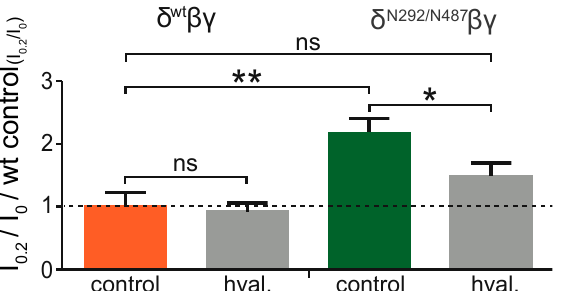
Figure 7. Degradation of hyaluronic acid of the ECM reduces the shear force response of channels containing the N292/N487 construct. Wild type δβγ ENaC and δ N292/N487 βγ expressing oocytes were treated with hyaluronidase (hyal., grey bars). Hyaluronidase treatment had no effect on the shear force response of wild type δβγ ENaC, but reduced the shear force effect of δ N292/N487 βγ (ns, p > 0.05; *, p < 0.05; **, p < 0.01; one-way ANOVA with multiple comparisons). Representative current traces of these experiments are depicted in Figure S2.